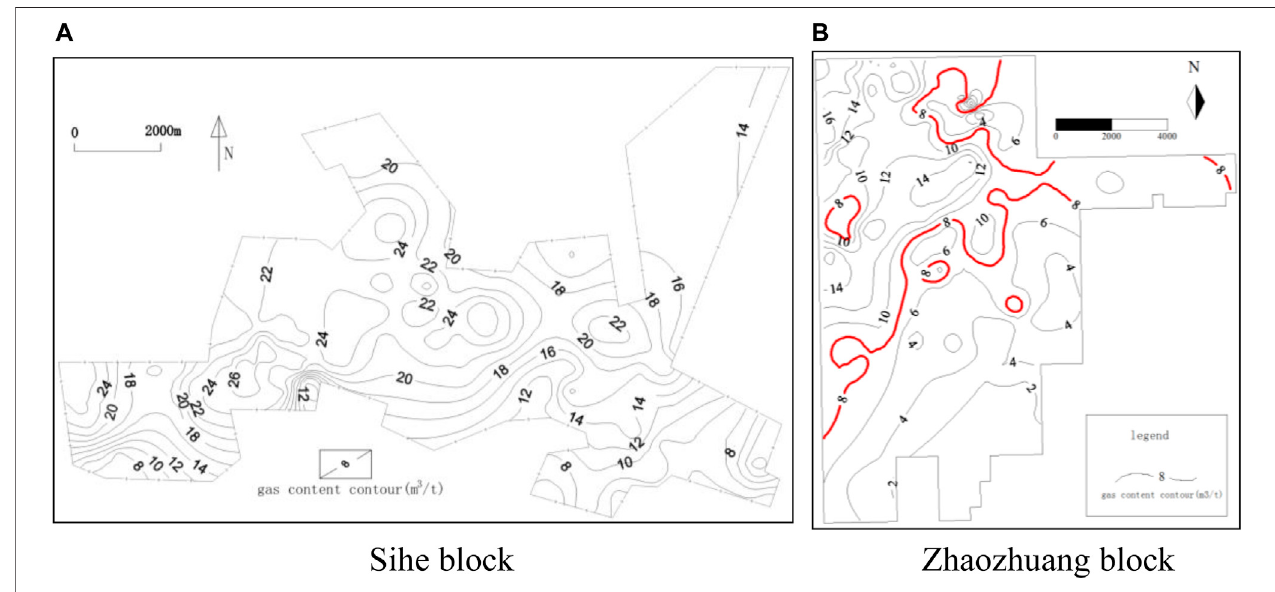
FIGURE 10 | Gas content of No.3 Coal Seam. (A) shie block. (B) Zhaozhuang block.